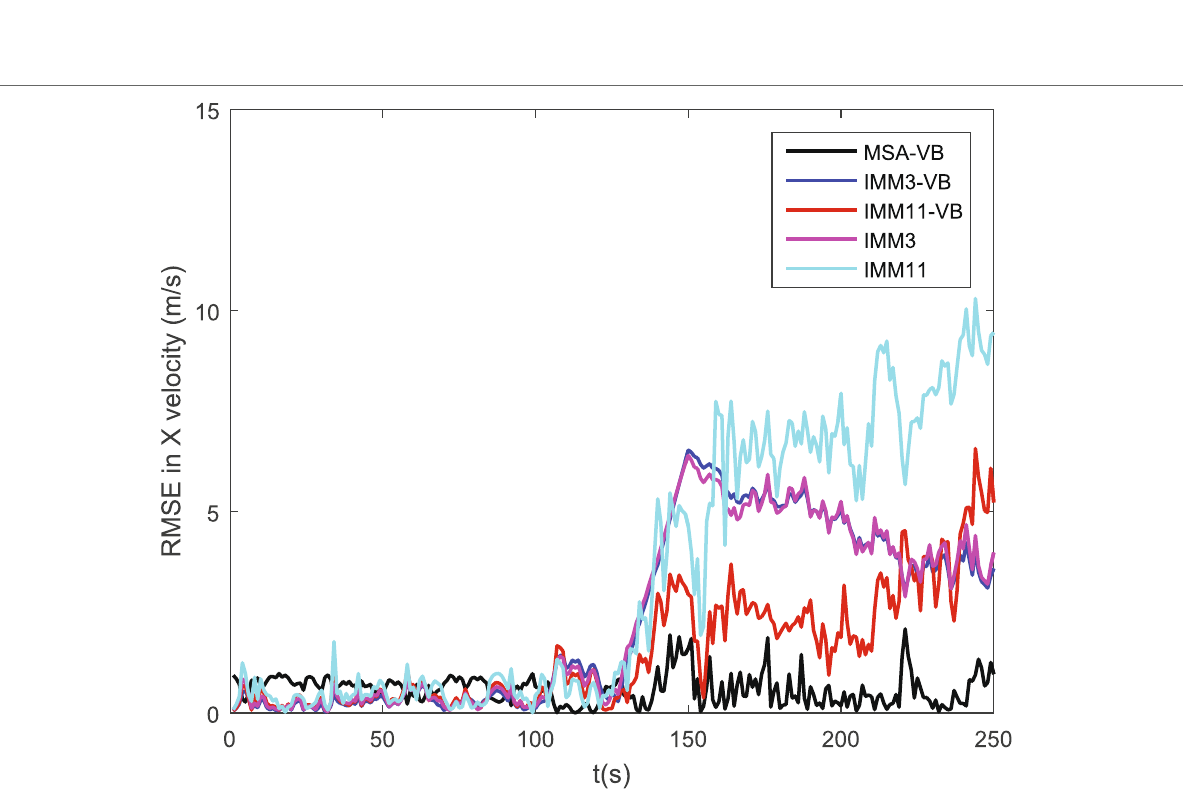
Fig. 8 RMSEs in X velocity of the proposed algorithm, IMM3, IMM11, IMM3-VB, and IMM11-VB in scenario